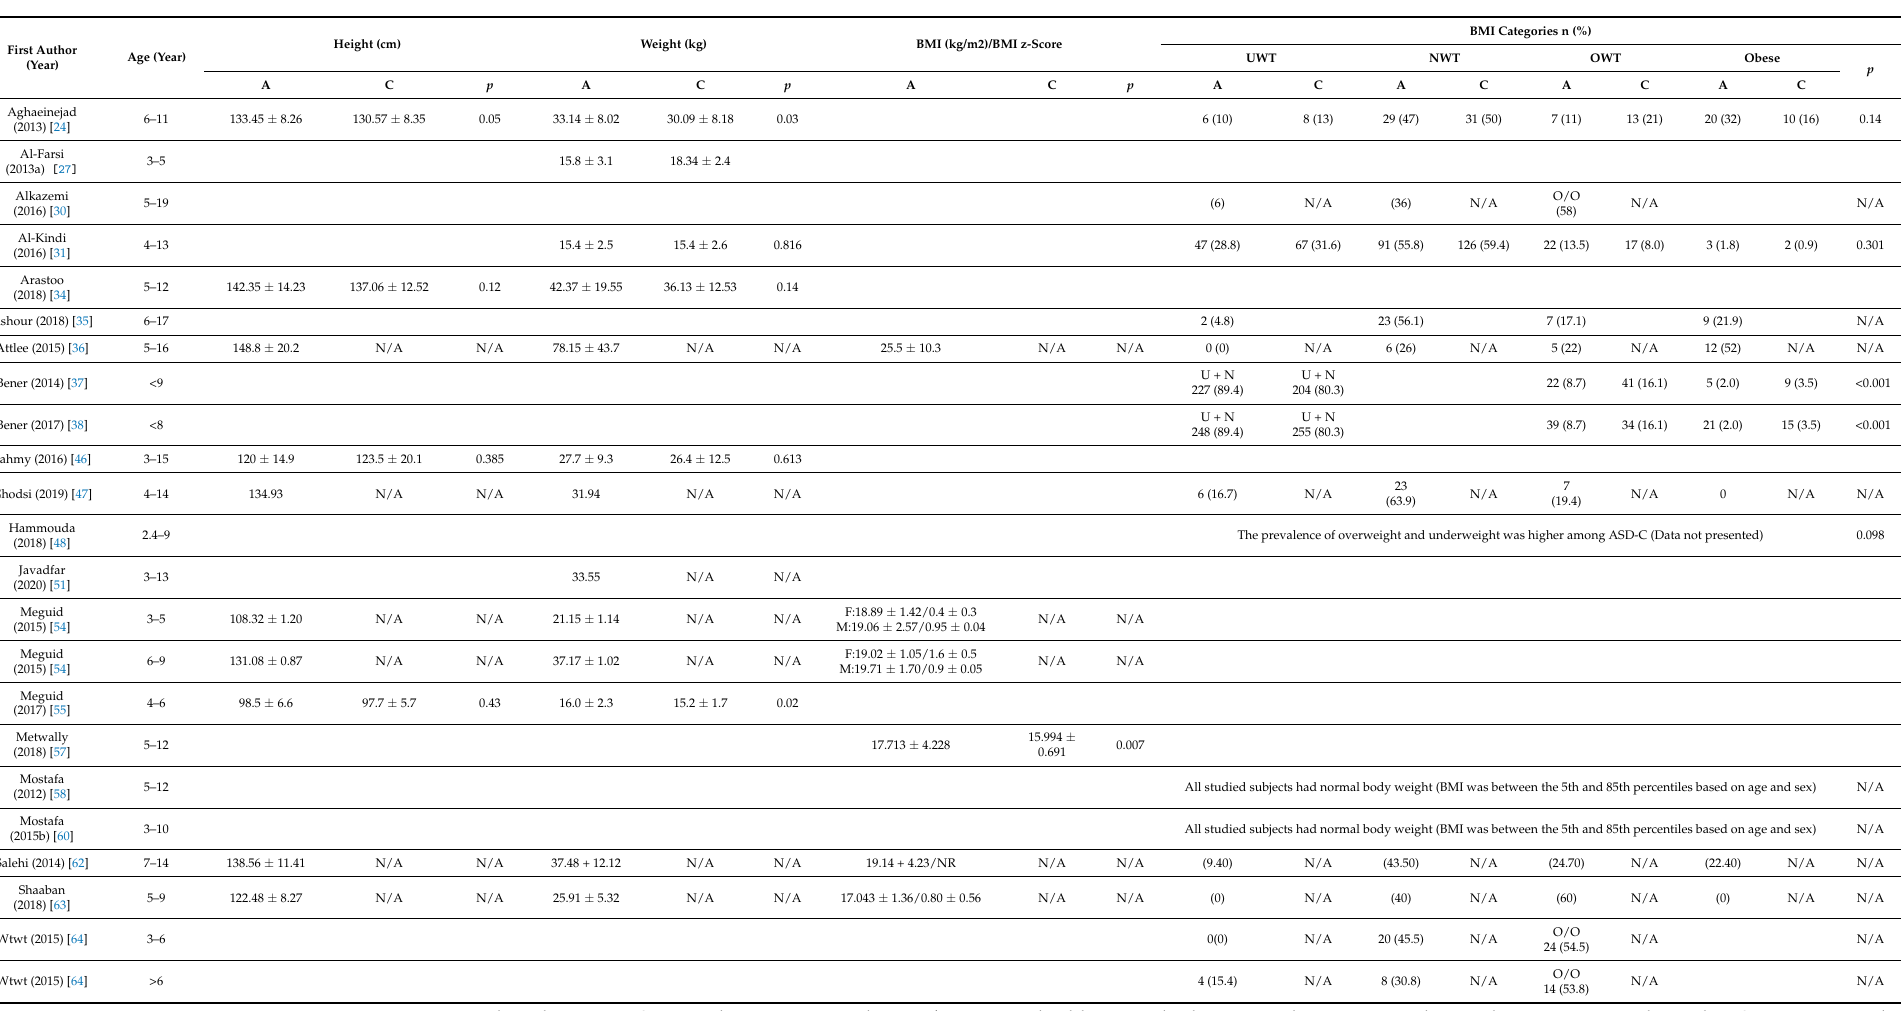
Table 3. Anthropometric data of children with autism spectrum disorder and controls in the MENA